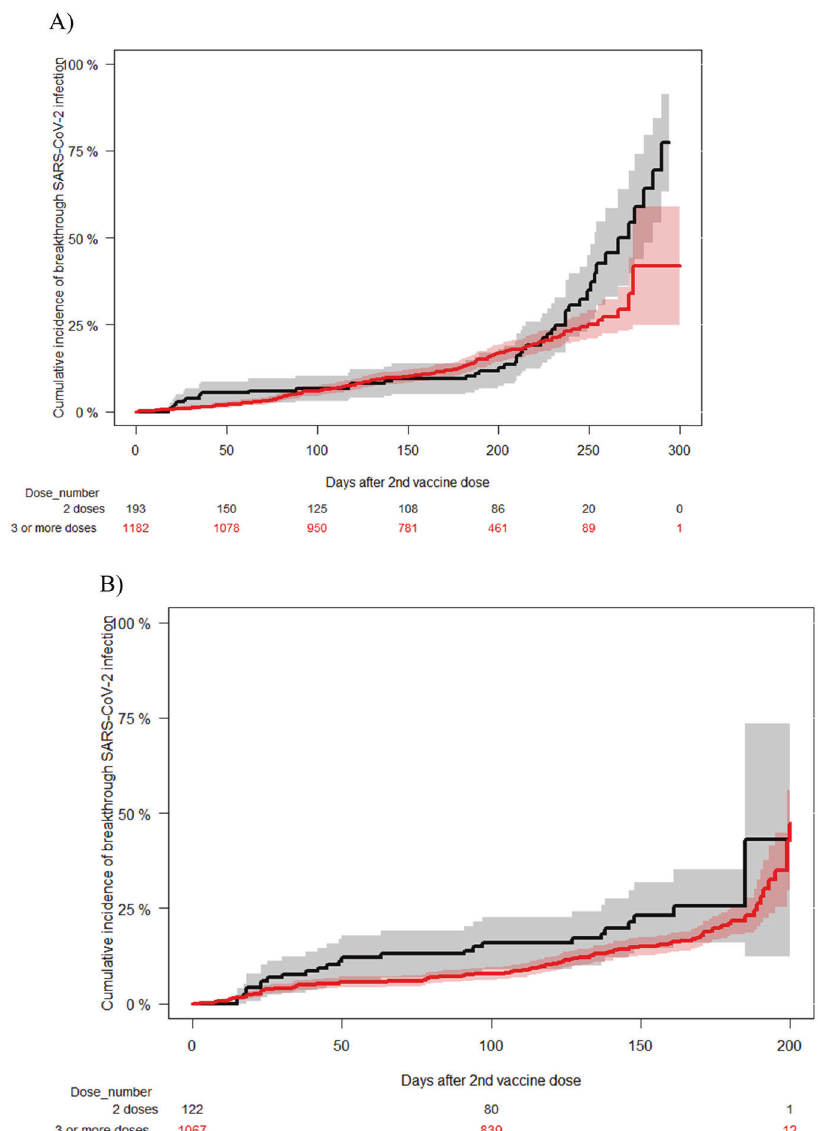
Fig. 4 Landmark analyses of cumulative incidence of SARS-CoV-2 breakthrough infection according to the vaccine dose status. A Estimated from the time of third vaccine dose for booster cases and from median time between the 2nd and 3rd vaccine dose for the control group. [3rd dose 18% (95% con fi dence interval 16 – 21%) vs 2 doses 18%, 95% C.I. 12 – 25 ( p = 0.1)]. B Estimated from December 26, 2021 in patients alive and without SARS-CoV-2 infection before the 3rd vaccine dose or before this date for the control group. [3rd dose 16% (95% con fi dence interval, 13 – 18%) vs 2 doses 23%, 95% C.I. 14 – 32 ( p =